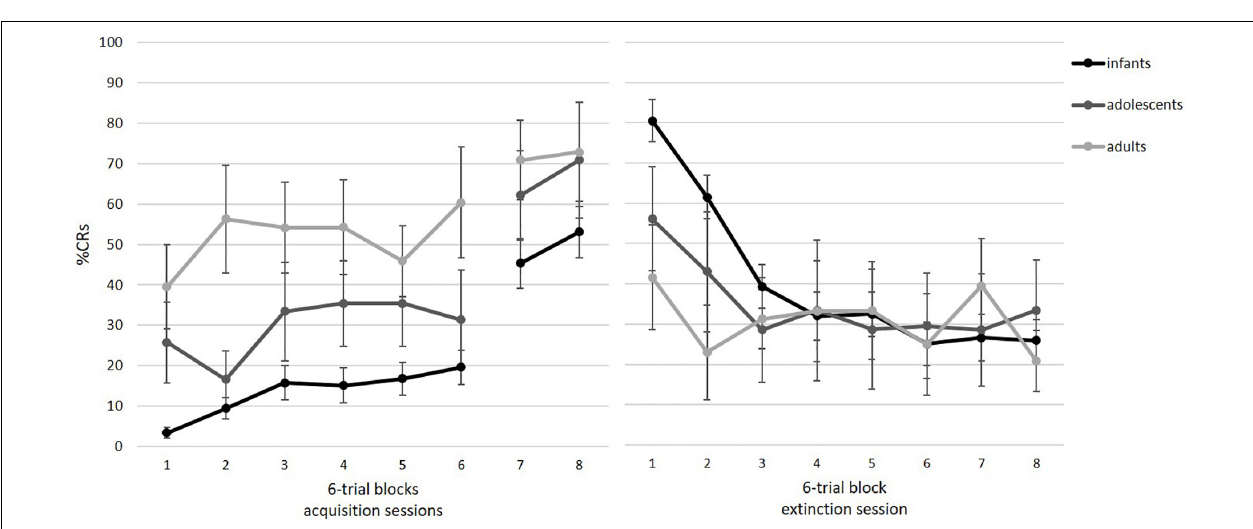
FIGURE 5 | Mean percent CRs for the acquisition (left) and extinction session (right) as a function of age group. Acquisition consisted of six blocks in session 1 and two blocks at the beginning of session 2. Acquisition: infants: n = 42, adolescents: n = 8, adults: n = 8. Extinction: infants: n = 26, adolescents: n = 7, adults: n = 8. Error bars represent SE of